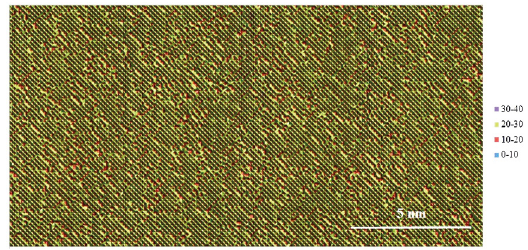
Figure 10. Calculated micrograph of the Al-20at.%Zn-10at.%Cu aged at 450 °C for 120000